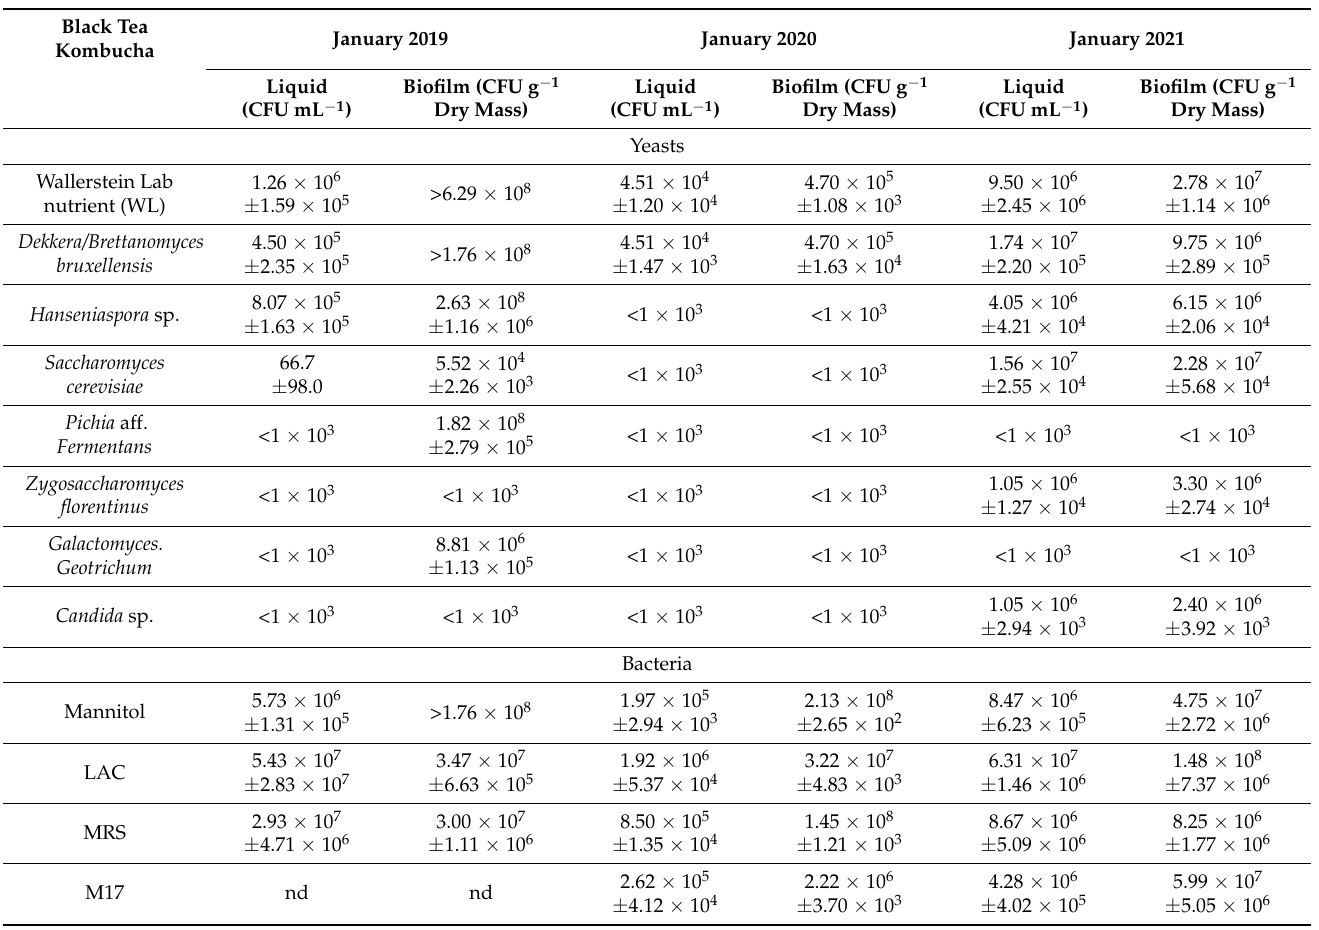
Table 2. Populations in yeasts and bacteria in black tea kombucha liquid and biofilm samples over three years (expressed as: average value ± confidence interval with α = 0.05). nd = not